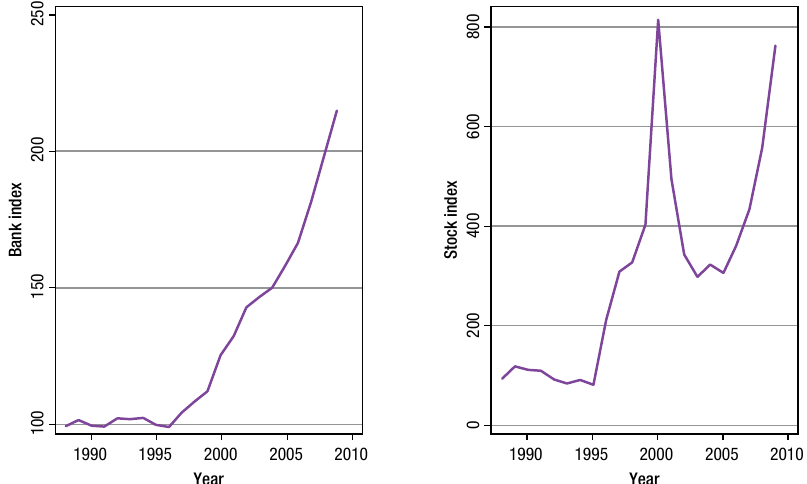
Fig. 1. Comparison of banking sector and stock market